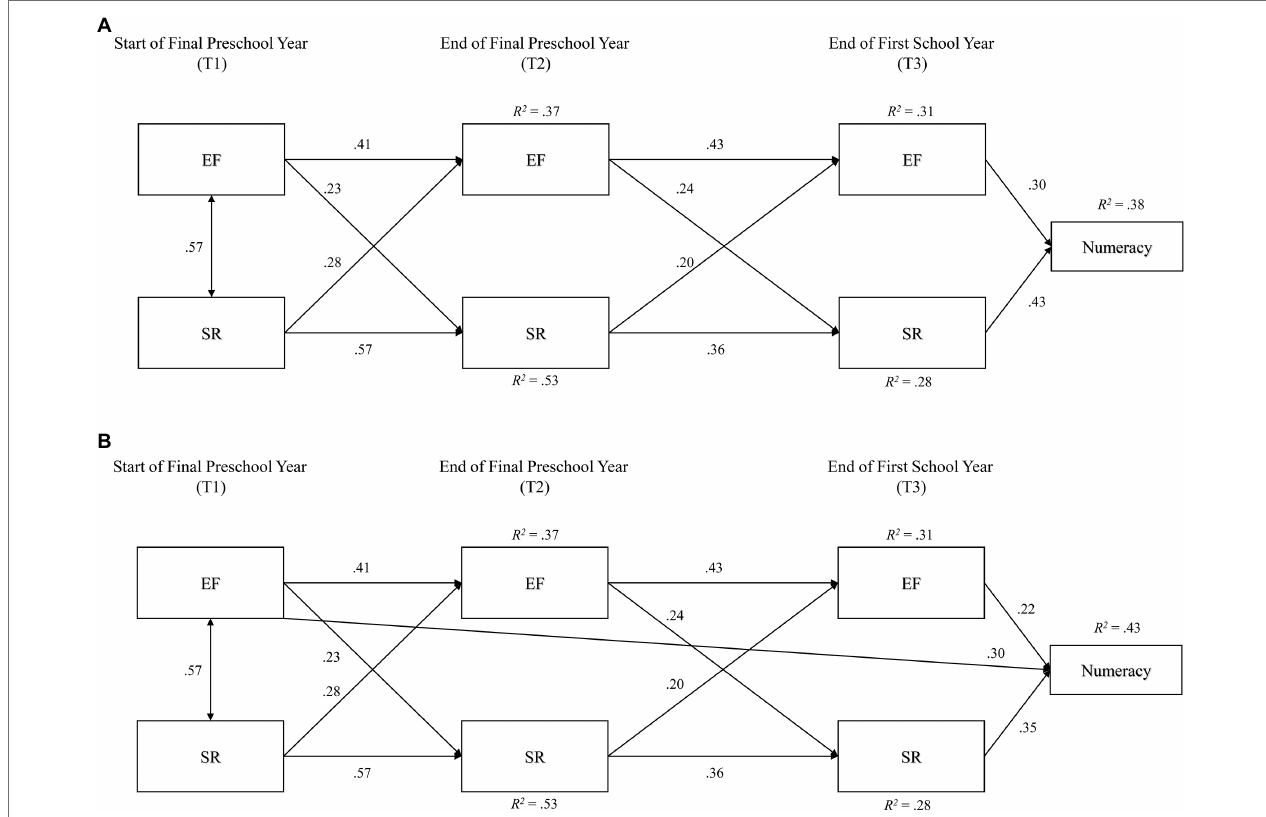
FIGURE 2 | Model 2: (A) cross-lagged panel model predicting numeracy. Model 2: (B) cross-lagged panel model predicting numeracy, with direct path from T 1 EF. Path loadings are standardized regression weights. Correlated error terms between T 2 and T 3 EF and SR were modelled but are omitted from this figure. EF, executive function composite index and SR, self-regulation composite